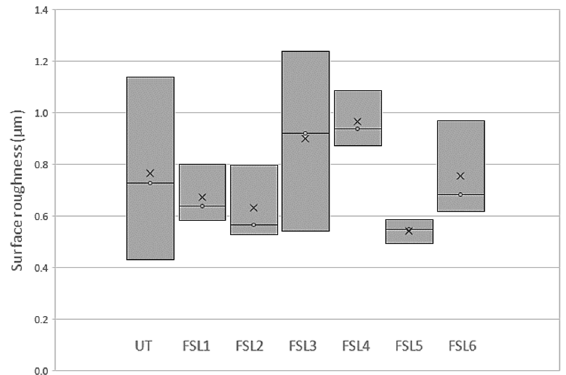
Figure 5. Surface roughness evaluation diagram.